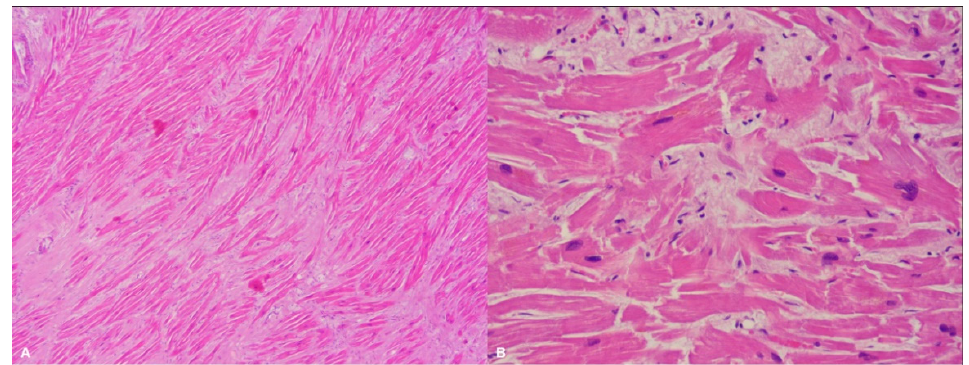
Figure 1. Left ventricle: diffuse disarray and mild fibrosis ( A ). Hematoxylin and eosin stain, 4× magnification), associated with focal and mild myocardial hypertrophy ( B ). Hematoxylin and eosin stain, 40× magnification) in a 48-year-old man who suddenly died while playing sport.